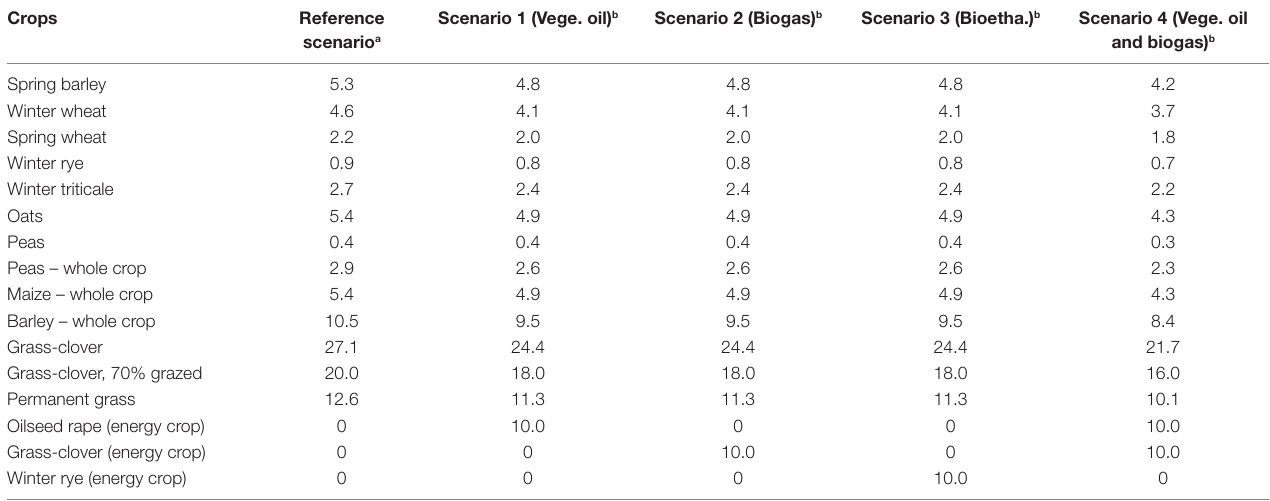
TaBle 1 | Mix of crops in percentage of total area in each